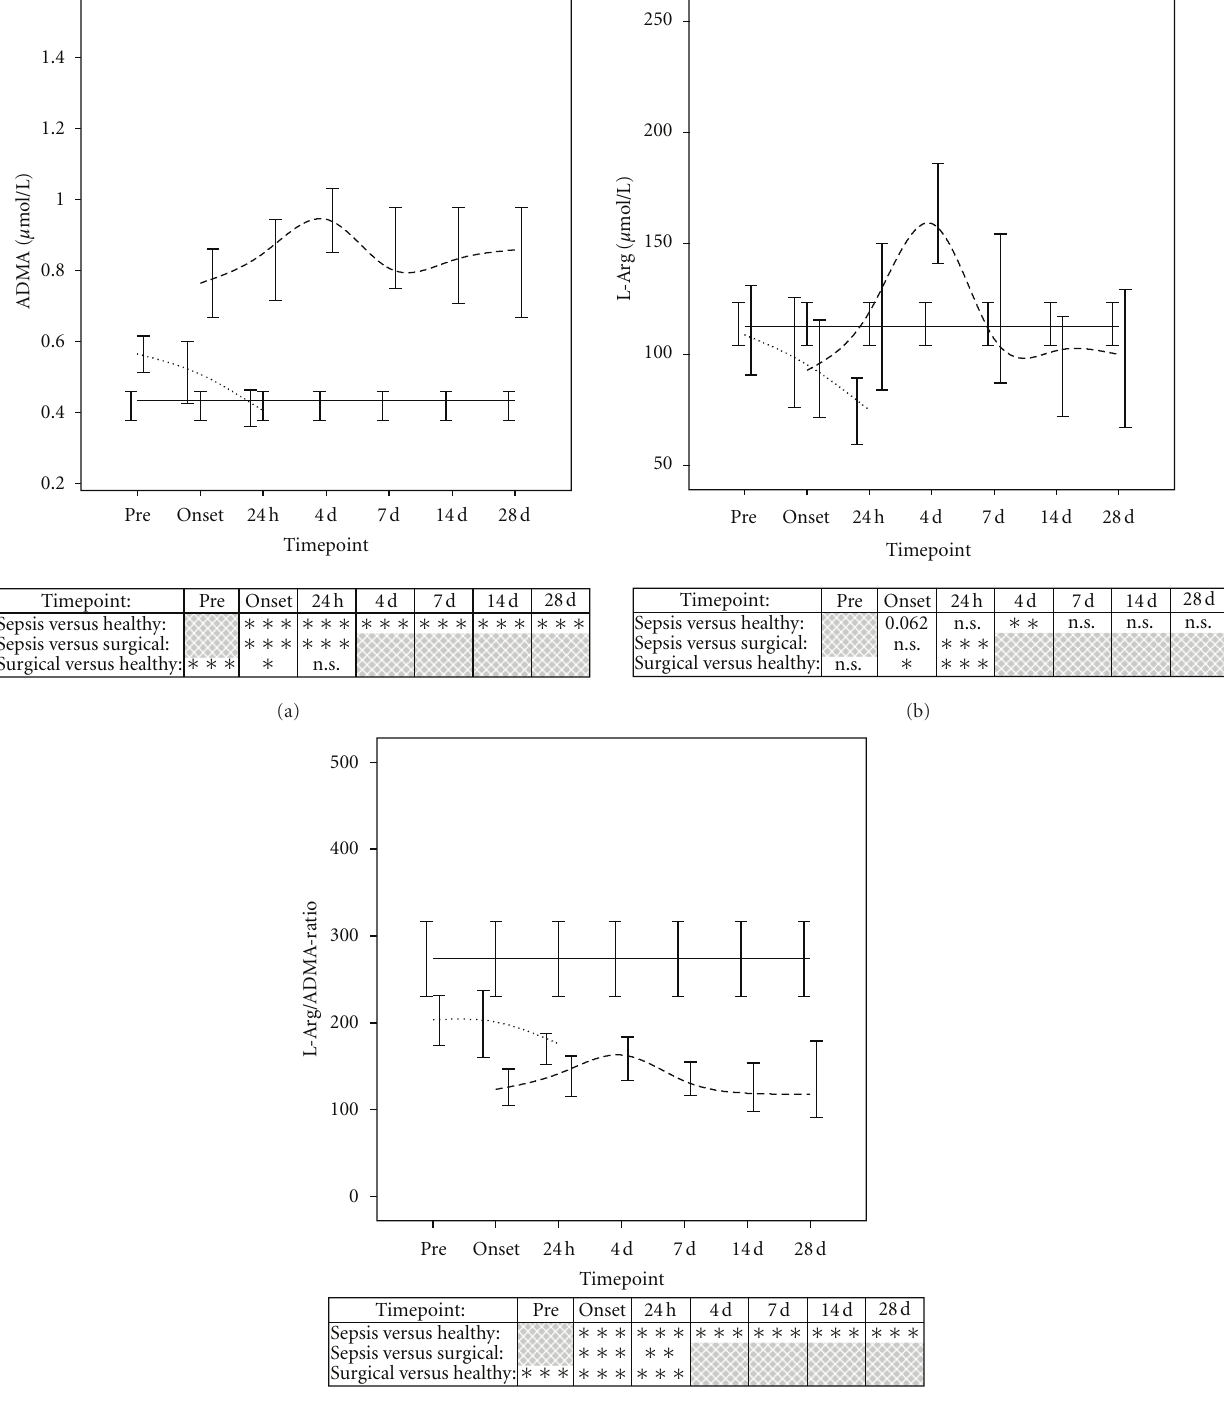
Figure 1: Comparison of ADMA (a) and L-arg (b) measurements as well as the resulting ratio of both (c) in healthy volunteers ( n = 30, black continuous line), patients following major abdominal surgery ( n = 30, short dashed line) and patients with septic shock ( n = 60, long dashed line). Data in line charts are given as medians and the 95% CI. Concerning symbolism and higher orders of significance: P < 0 . 05: ∗ , P < 0 . 01: ∗∗ , P < 0 . 001: ∗∗∗ , n.s.: not statistically